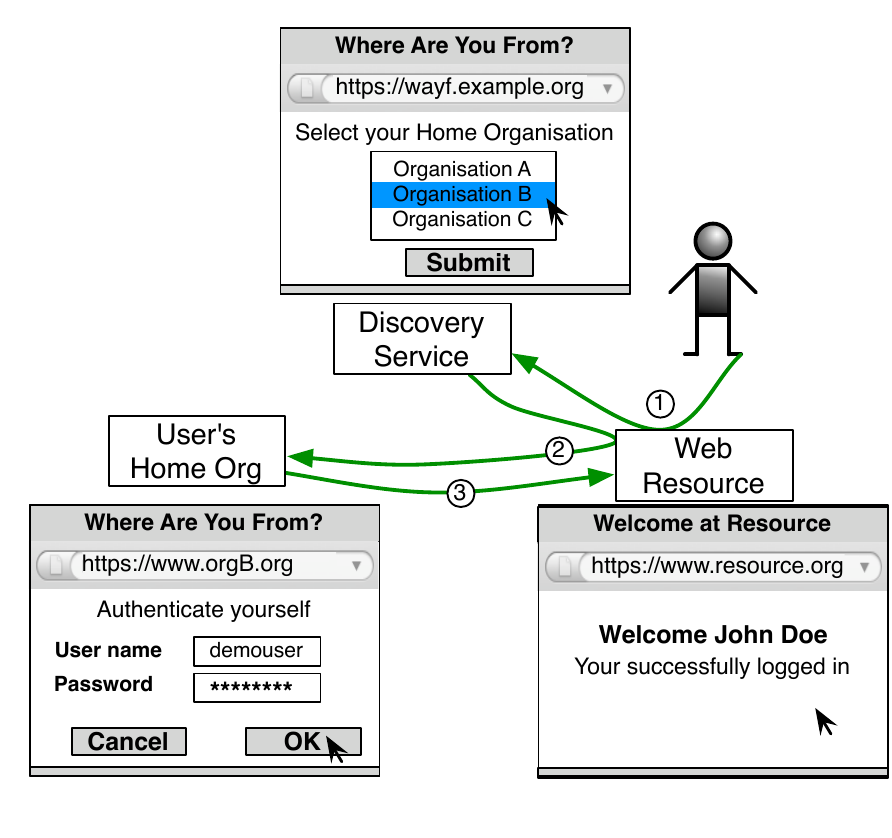
Figure 3. Authentication